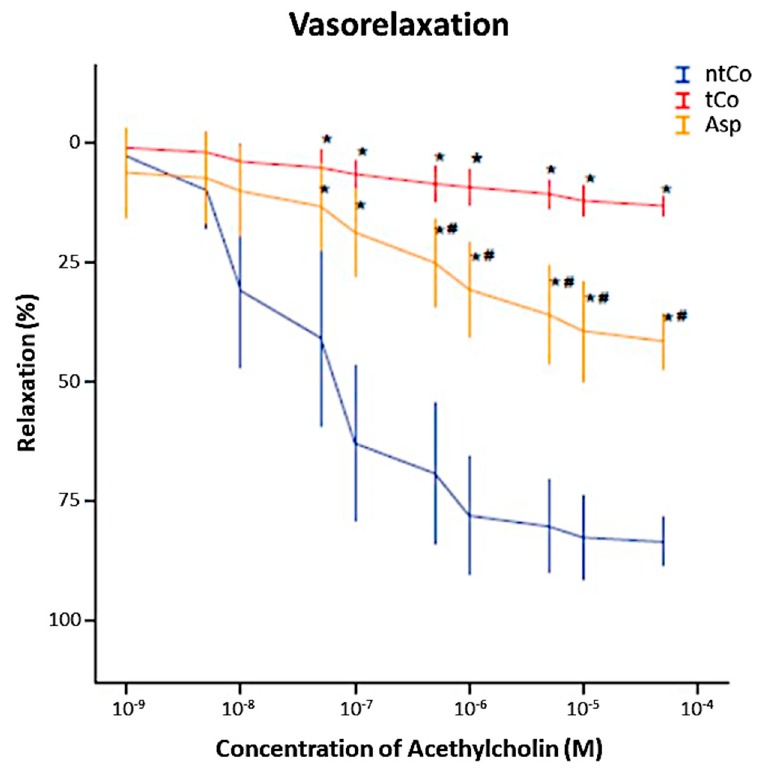
Figure 2. Result of the organ bath functional measurement. Aspirin pretreatment resulted in a significantly better graft function compared to the tCo group. * p < 0.05 vs. ntCo, # p < 0.05 vs. tCo.